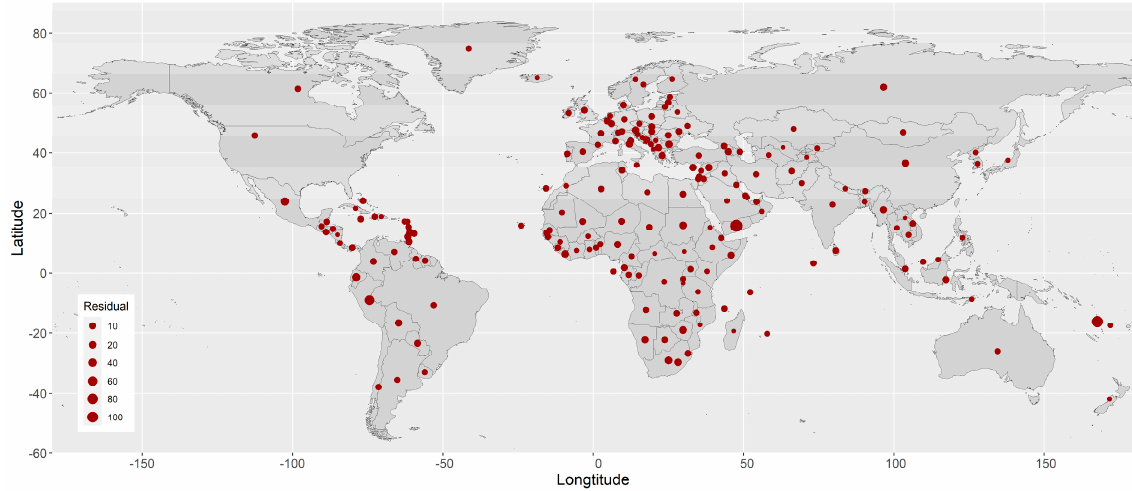
Figure 3. Residuals from the common (non-spatial) multivariate linear regression model.